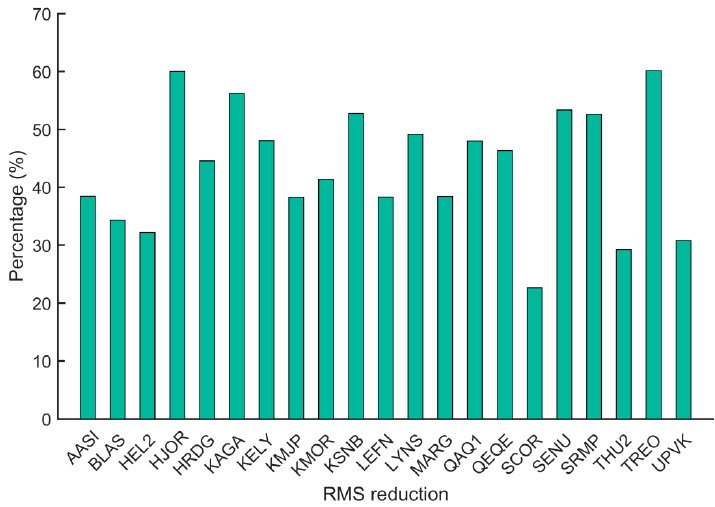
Figure 4. RMS reduction change of the GPS coordinate residual after filtering processing.